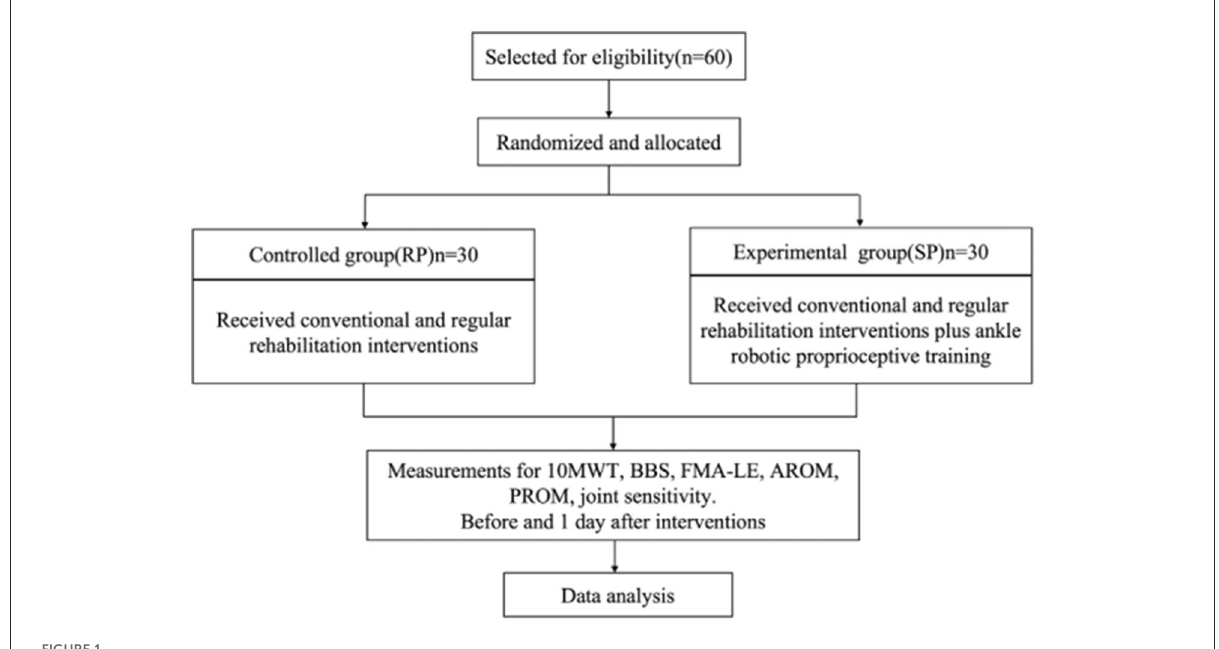
FIGURE1 Flowchart of the